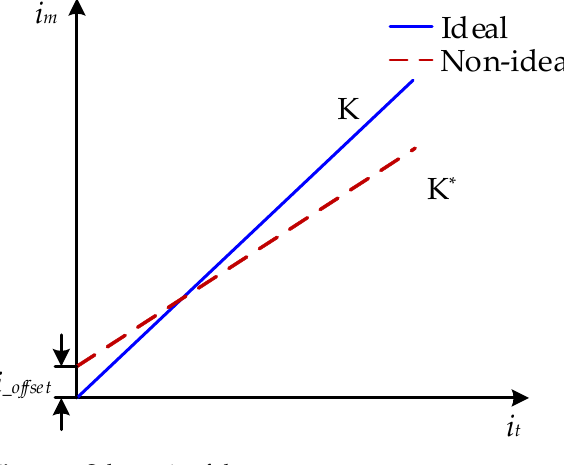
Figure 7. Schematic of the current measurement error.